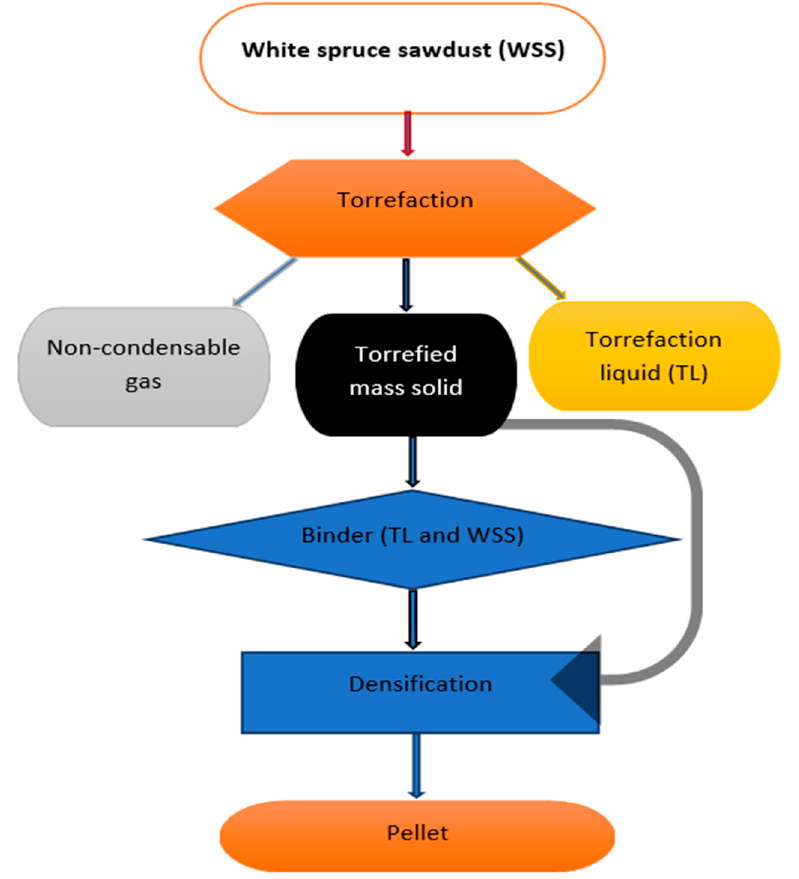
Figure 1. Torrefaction and pelletization process for white spruce sawdust.